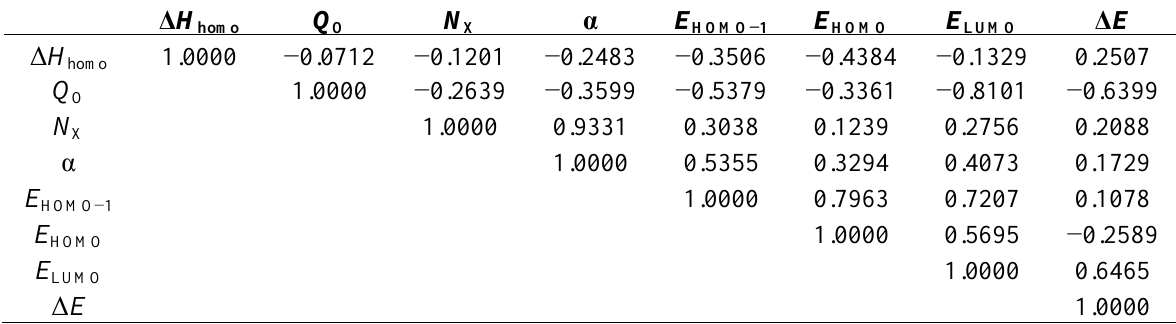
Table 3. Correlation matrix between the selected molecular